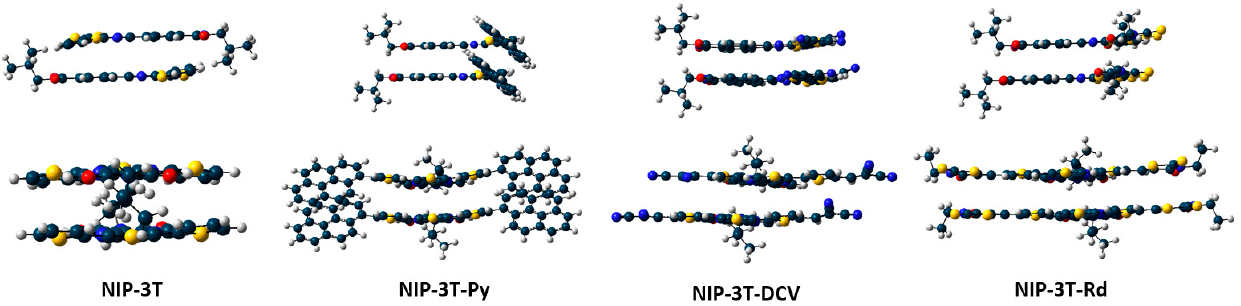
Figure 17. Dimeric configuration calculated for the D-A-D and A2-D-A1-D-A2 semiconductors described in this section. Reproduced from [32] with permission from The Royal Society of Chemistry. blies have been compared to those of the NIP-3T building block (Tables 9 and 10). For